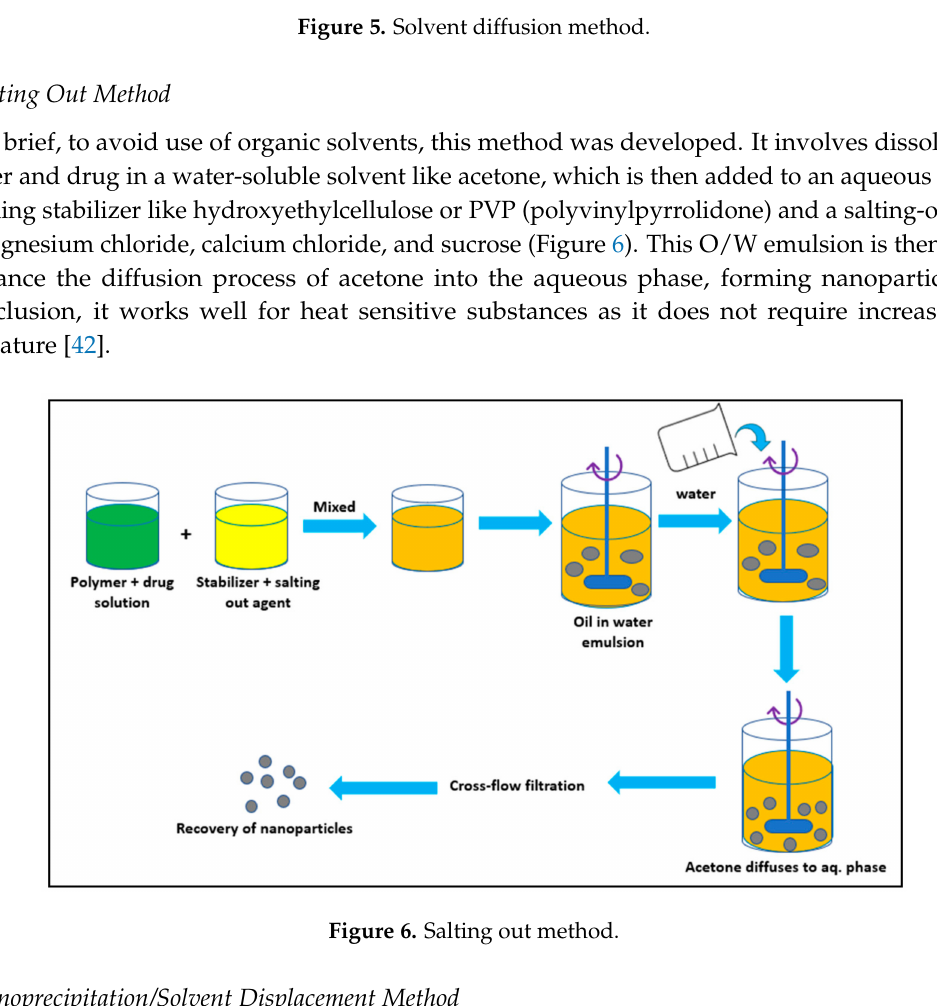
Figure 5. Solvent diffusion method.